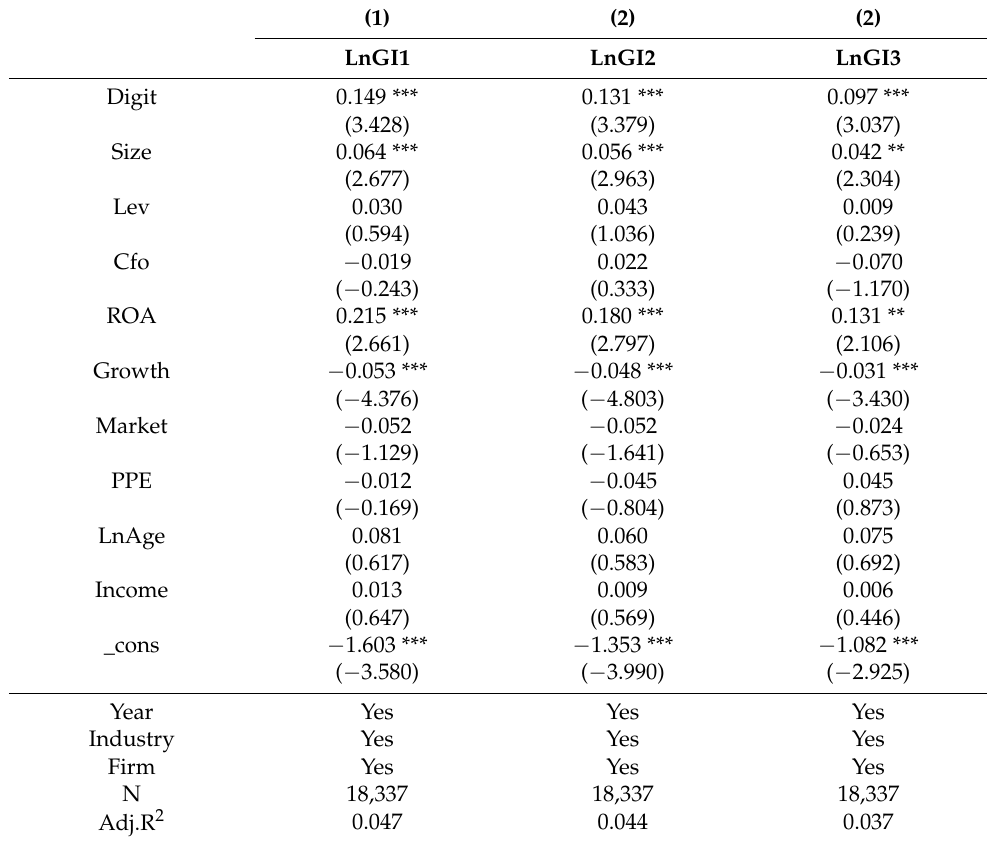
Table 3. Corporate digital transformation and green innovation .